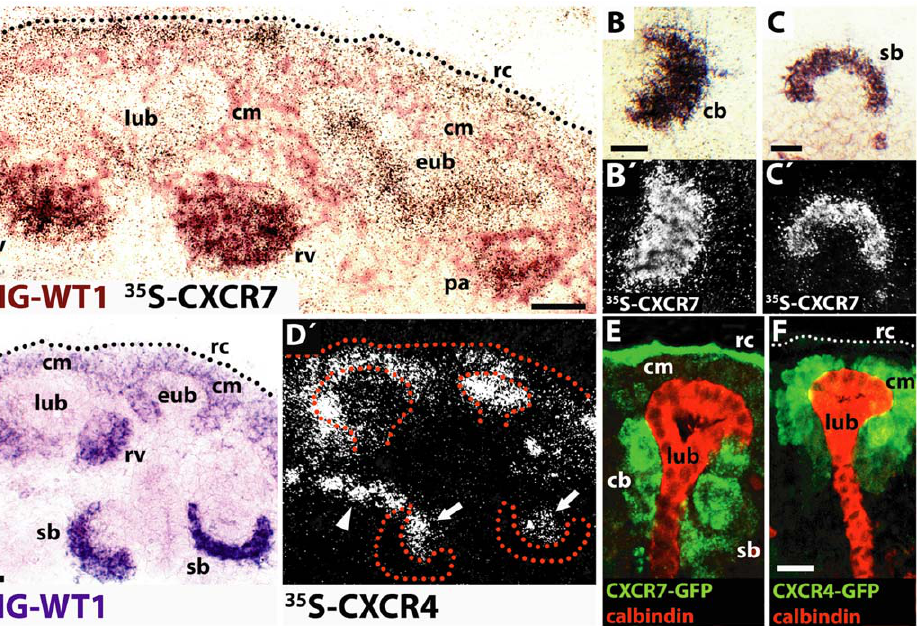
Figure 2. Differential expression of CXCR7 and CXCR4 in nephrogenic mesenchyme, ureteric bud, and forming glomeruli. (A–D) A digoxigenin (DIG) labeled WT1 antisense probe was used as a marker for mesenchymal and mesenchyme derived nephrogenic structures at E14.5 and co-hybridized with 35 S labeled probes for CXCR7 or CXCR4. ( A ) Strong CXCR7 signals (black grains) are present in a T-shaped WT1 negative early ureteric bud tip (eub) which is associated with a CXCR7/WT1 co-positive pretubular aggregate (pa; black grains/brown staining). Weaker CXCR7 expression is found in a late ureteric bud tip (lub) which is associated with CXCR7/WT1 co-positive renal vesicles (rv). Note weak CXCR7 mRNA expression in the cap mesenchyme (cm) and strong CXCR7 gene activity above the cm (brown staining) at the renal capsule (rc). ( B,B 9 ,C,C 9 ) Bright- and darkfield views of a comma-shaped body (cb in B) and S-shaped body (sb in C) after hybridization with a DIG labeled WT1 probe and a 35 S labeled CXCR7 riboprobe (black grains in B,C; white grains in B 9 ,C 9 ). Both WT1 positive structures exhibit clear CXCR7 antisense mRNA signals. ( D,D 9 ) Bright- and darkfield micrographs showing WT1-positive renal tissue (D) and radiosignals of CXCR4 riboprobe (D 9 ). Strong CXCR4 gene expression is detected in a WT1 negative early ureteric bud tip (eub in D, dotted line in D 9 ). Weak CXCR4 labeling is seen in a late ureteric bud tip (lub) which is associated with a WT1 positive/CXCR4 negative renal vesicle (rv). Note that CXCR4 mRNA is also present in WT1 positive cap mesenchyme (cm). WT1 positive epithelial cells of S-Shaped bodies display no CXCR4 mRNA expression. The vascular cleft of S-shaped bodies (arrows in D 9 ) as well as putative arterioles (arrowhead in D 9 ) are CXCR4 positive. ( E , F ) GFP immunostaining in sections from BAC transgenic mice expressing EGFP under the control of the CXCR7 promotor (G) or CXCR4 promotor (H). Calbindin was co-stained as an ureteric bud marker. ( G ) CXCR7-GFP is highly expressed in the renal capsule (rc) as well as in comma- and S-shaped bodies (cb, sb) associated with a calbindin positive late ureteric bud (lub). CXCR7-GFP is weak expressed in cap mesenchyme (cm) and not present in the late ureteric bud. ( H ) Strong CXCR4-GFP signals are detected only in